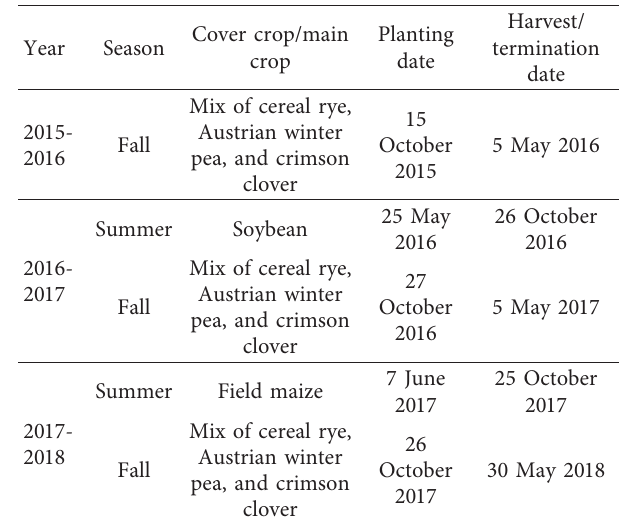
Table 1: Soil sampling, and cover crop planting and termination